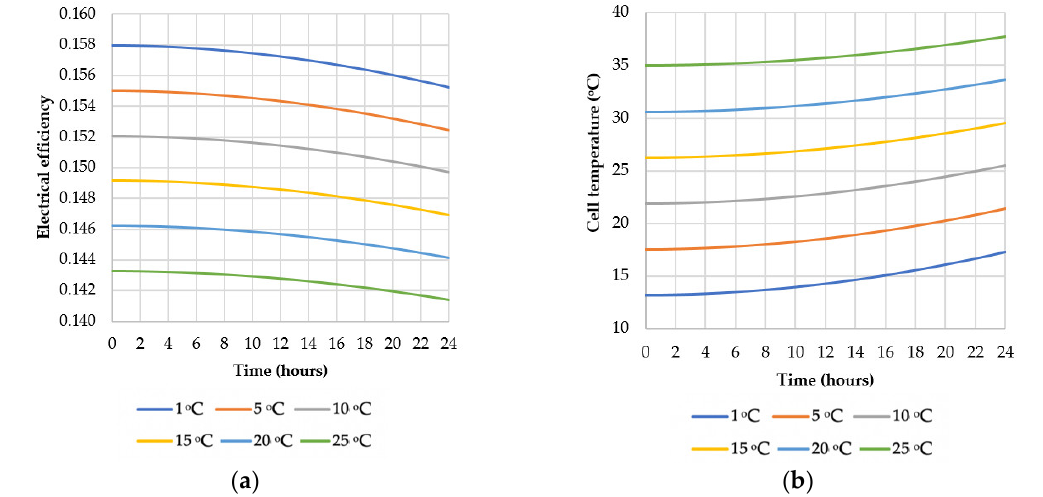
Figure 4. Daily variation ( a ) of electrical efficiency; ( b ) of cell temperature.